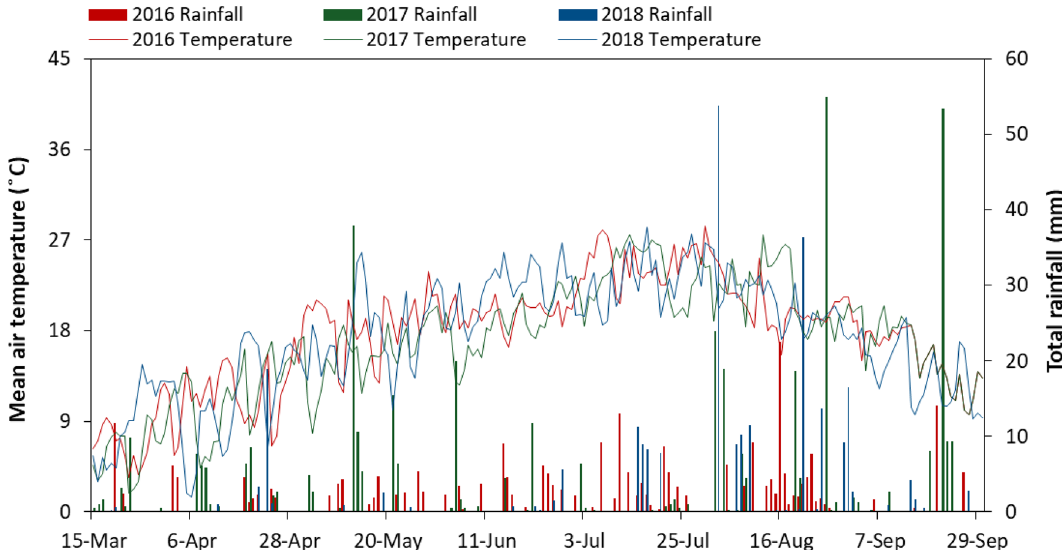
Figure 1. Mean air temperature and rainfall during the growing season after harvesting of spring wheat in 2016, 2017, and 2018 at Wuwei experimental station, northwestern, China.